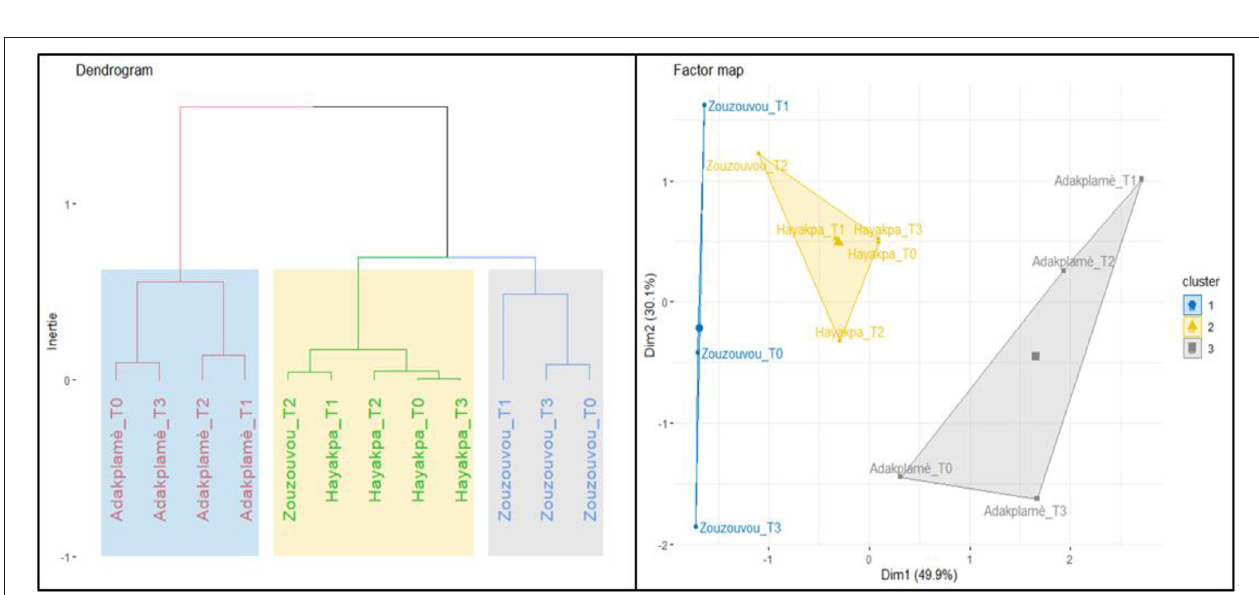
FIGURE 9 | Classification of different growth and yield parameters based on their performance. T 0 :100% NPK + Urea; T 1 : clay + P. putida + ½ NPK + Urea, T 2 : peat + P. putida + ½ NPK + Urea, T 3 : clay-peat + P. putida + ½ NPK + Urea.